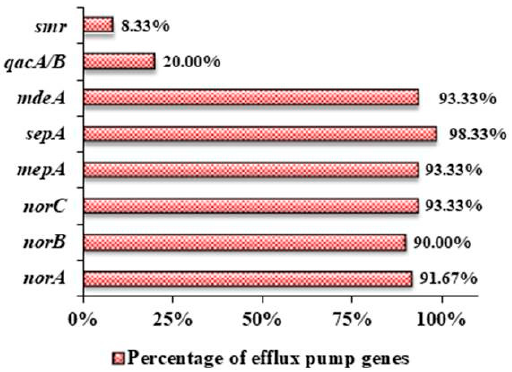
Figure 3. Prevalence of different efflux pump genes in the clinical isolates of S. aureus . Irrespective of their resistance status, the most effective combination of efflux pump genes was chromosomal encoded norA + norB + norC + mepA + sepA + mdeA among the